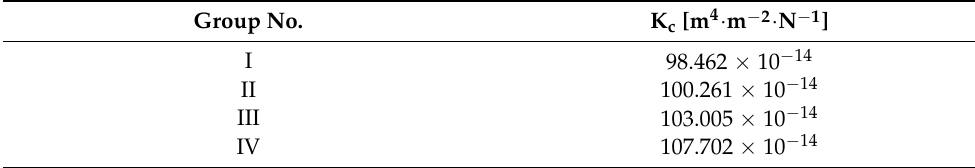
Table 7. Calculated abrasive wear rate values. Group